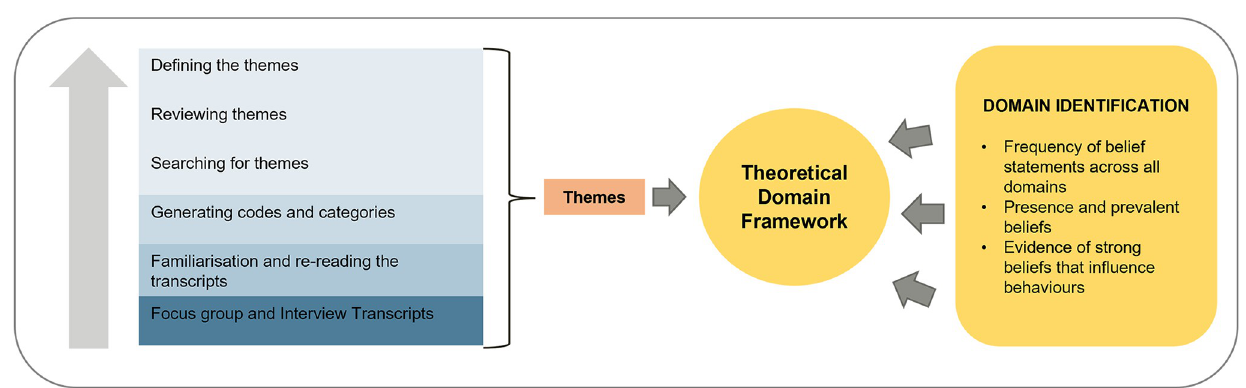
Fig 1. The two-stage hybrid inductive and deductive analysis. First, themes were inductively identified. This began with familiarisation with and re- reading the transcripts, followed by an initial coding and grouping of common codes into emergent themes. Next, a deductive approach was used to link the naturally occurring themes to domains of the Theoretical Domains